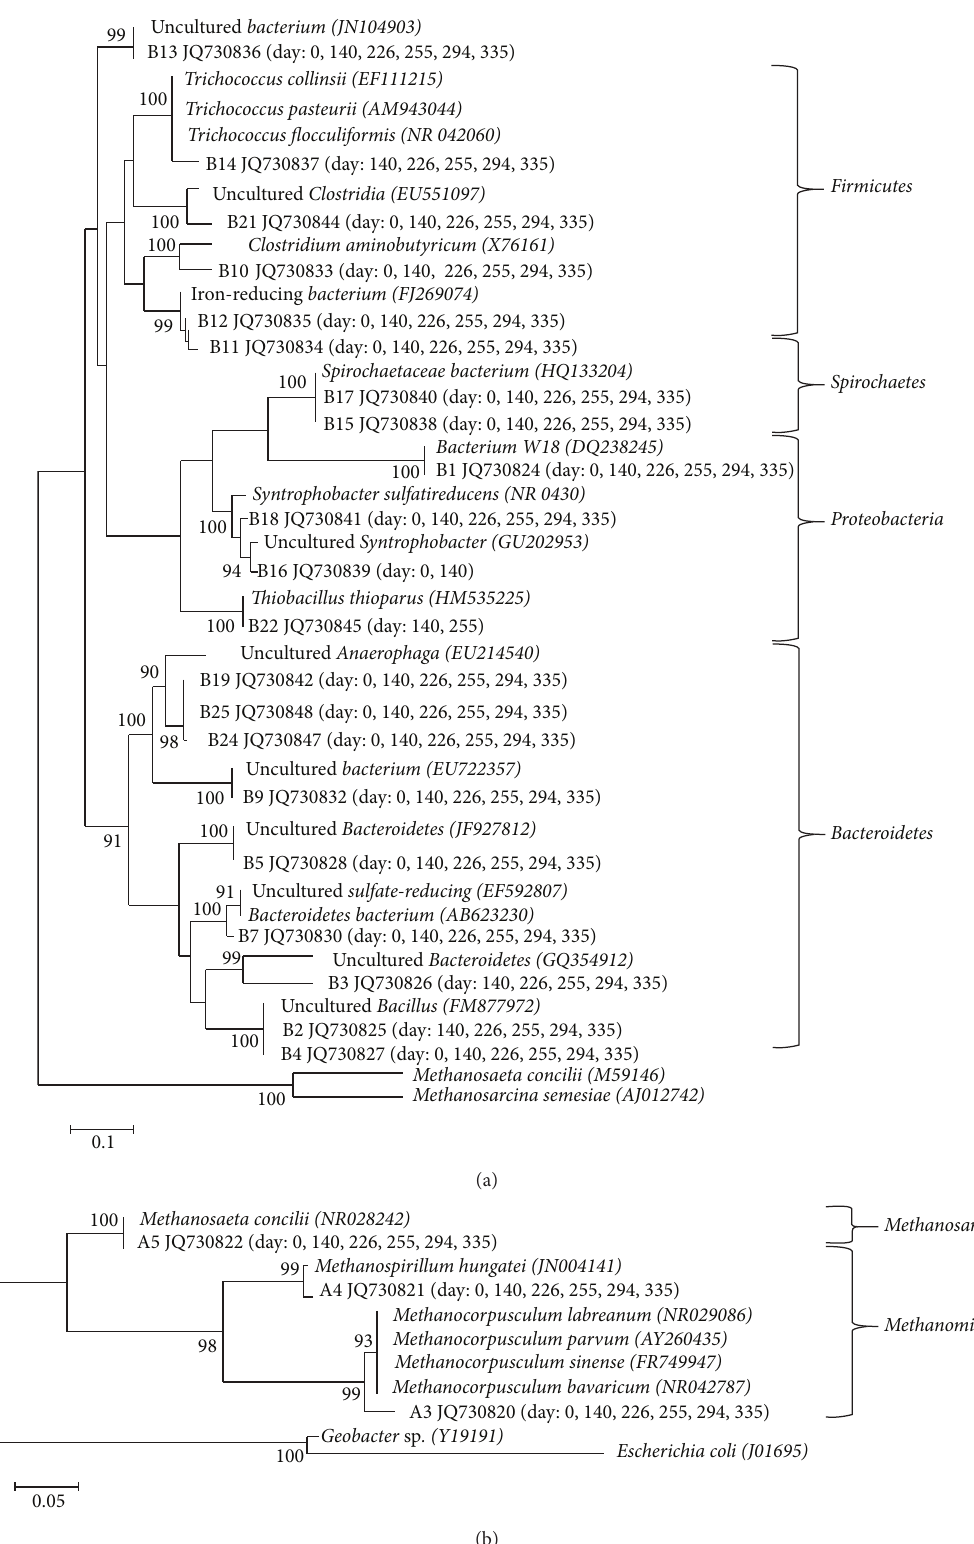
Figure 5: Neighbor joining tree illustrating the phylogenetic affiliations of the 16S rRNA gene sequences obtained from (a) bacterial DGGE